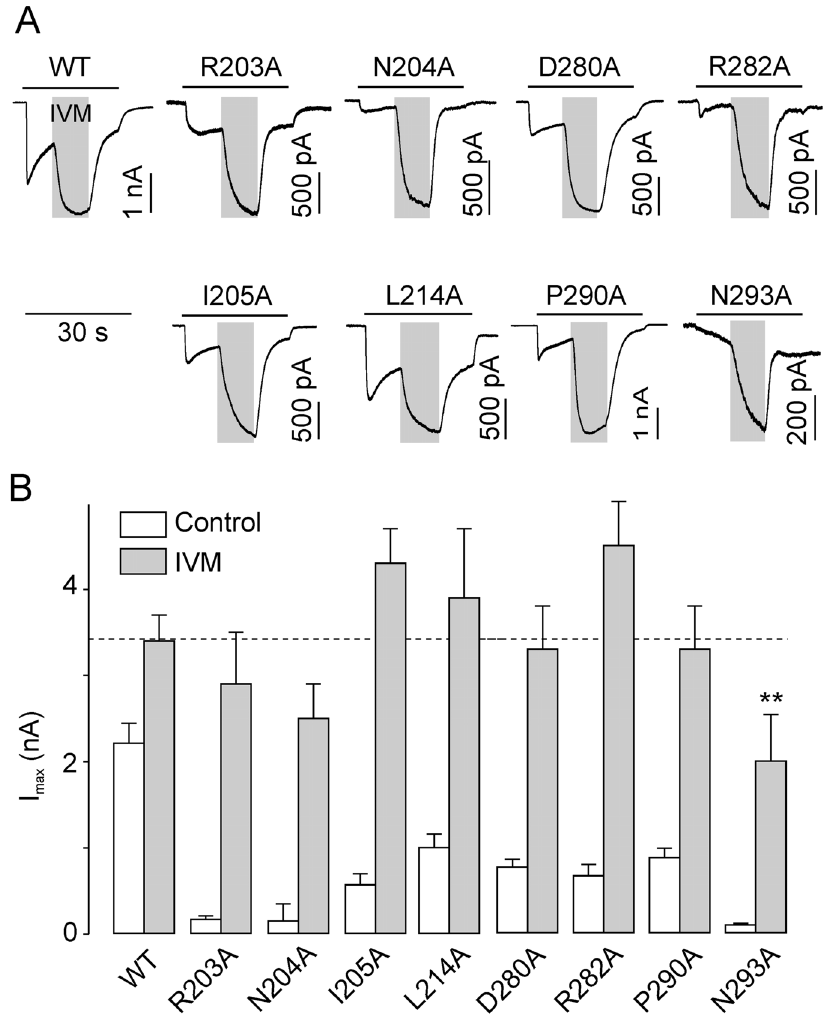
Figure 4. Ivermectin rescues the I max of low-functioning mutants. (A) Acute effect of 3 m M ivermectin (IVM) applied for 10 s (gray areas) during ongoing stimulation with 100 m M ATP for 30 s (horizontal bars) in cells expressing the WT, the DF mutants (R203A, N204A, I205A, and L214A), or the LF mutants (D280A, R282A, P290A and N293A). Recordings are examples of traces similar to 3–5 traces per mutant and 30 per WT receptor. (B) Summary data showing the potentiating effect of IVM preapplication (for 4–6 min) on I max in WT and alanine mutant receptors. The I max values were derived from measurements taken in the absence (open bars) or in the presence (filled bars) of IVM. Values are presented as the mean 6 SEM from 5– 8 measurements per mutant and 15 measurements per WT. IVM treatment rescued the I max of all low-functioning receptors, except in the case of N293A, which is an ATP binding mutant. The statistical significance was determined by an ANOVA comparing the WT I max and the I max of mutant receptors in the presence of IVM. **, p ,